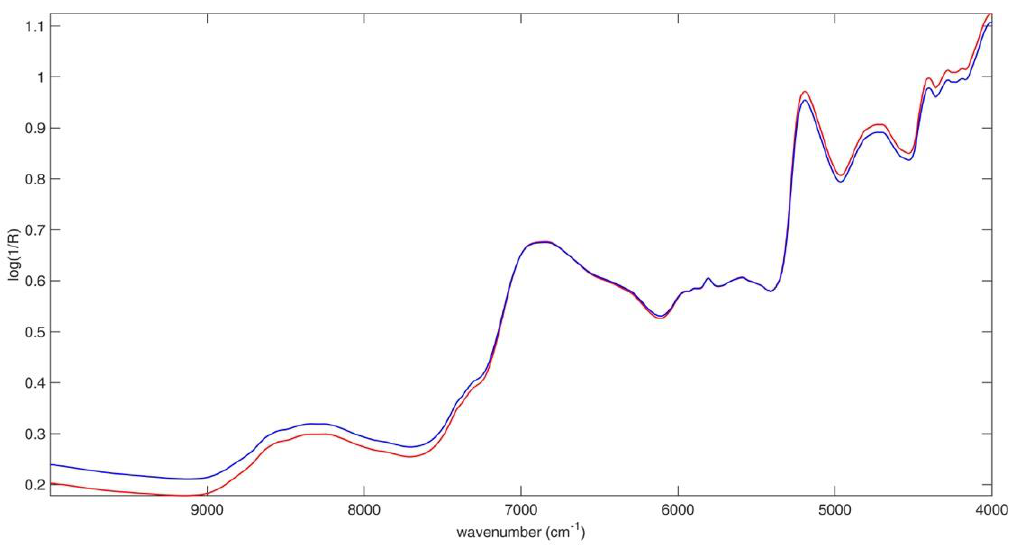
Figure 1. Average raw spectra collected on Sorrento (blue line) and Non-Sorrento (red line) walnuts (nutshell).